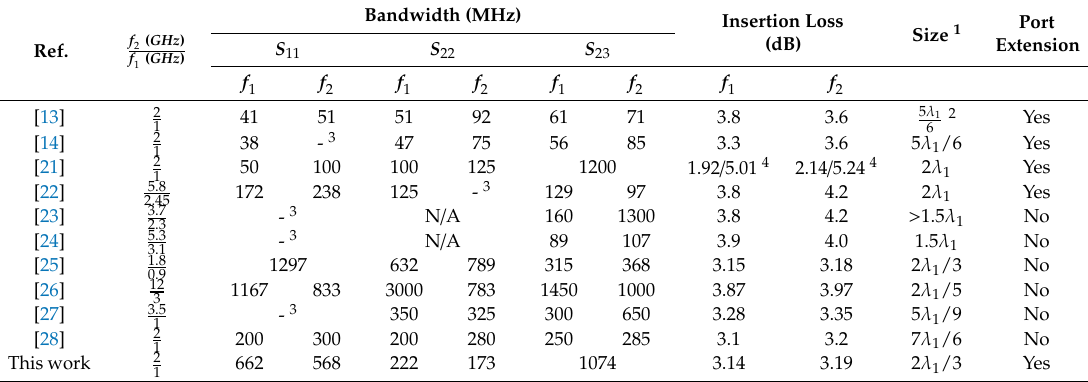
Table 2. Performance comparison of the fabricated prototype with previous publications.